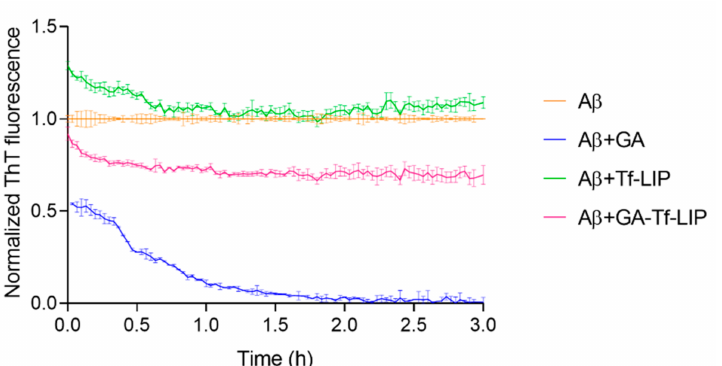
Figure 8. Normalized ThT fluorescence of mature A β 1-42 fibrils (orange data) as a function of time (h) upon incubation with GA (blue data), Tf-functionalized liposomes (green data), and GA-loaded Tf-functionalized liposomes (pink